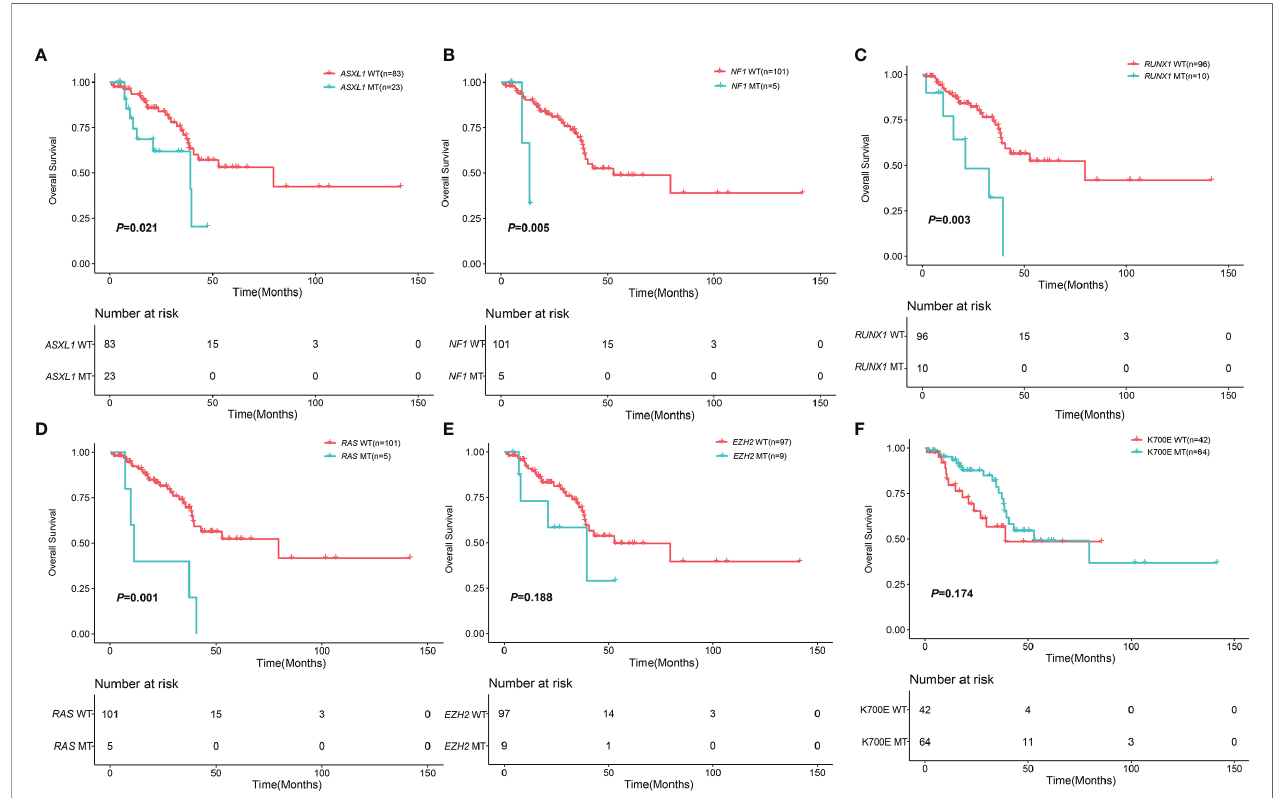
FIGURE 3 | Impact of mutations on OS in 106 MDS patents with SF3B1 mutation. (A) Kaplan-Meier curves comparing the OS of patients with ASXL1 mutation (blue) compared with wild type (red) (39.03 months vs. 79.60 months, P = 0.021). (B) Kaplan-Meier curves comparing the OS of patients with NF1 mutation (blue) compared with wild type (red) (13.17 months vs. 52.77 months, P = 0.005). (C) Kaplan-Meier curves comparing the OS of patients with RUNX1 mutation (blue) compared with wild type (red) (21.03 months vs. 79.60 months, P = 0.003). (D) Kaplan-Meier curves comparing the OS of patients with KRAS / NRAS mutation (blue) compared with wild type (red) (11.33 months vs. 79.60 months, P = 0.001). (E) Kaplan-Meier curves comparing the OS of patients with EZH2 mutation (blue) compared with wild type (red) (39.57 months vs. 52.77 months, P = 0.188). (F) Kaplan-Meier curves comparing the OS of patients with SF3B1 K700E mutation (blue) compared with non SF3B1 K700E (red) (52.77 months vs. 39.03 months, P =